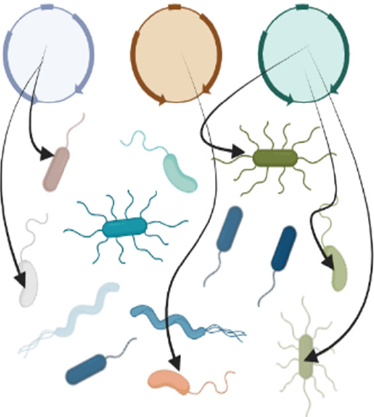
Figure A3. Considering preferred distance between RBS and start codon as well as mRNA ‐ ribo ‐ some binding energy, affected by mRNA folding, to design a plasmid tailored for facilitating pro ‐ tein translation initiation in wanted hosts.